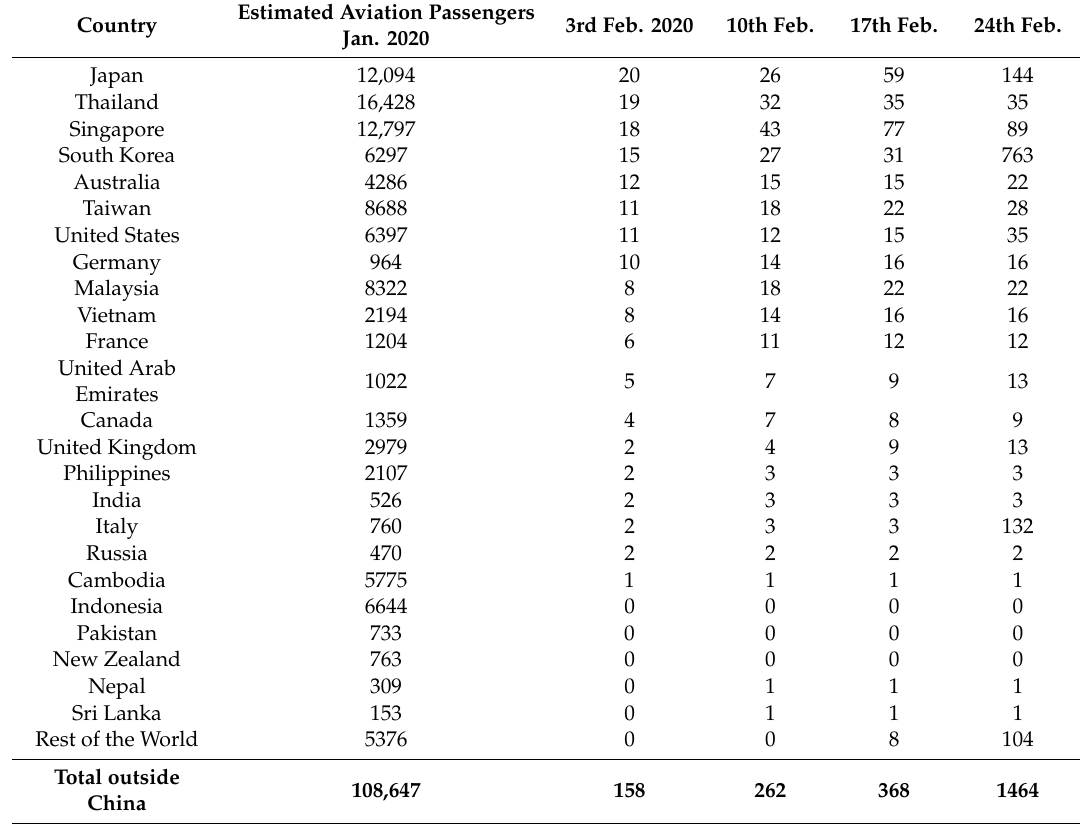
Table 5. Estimated passengers and number of reported cases, other main